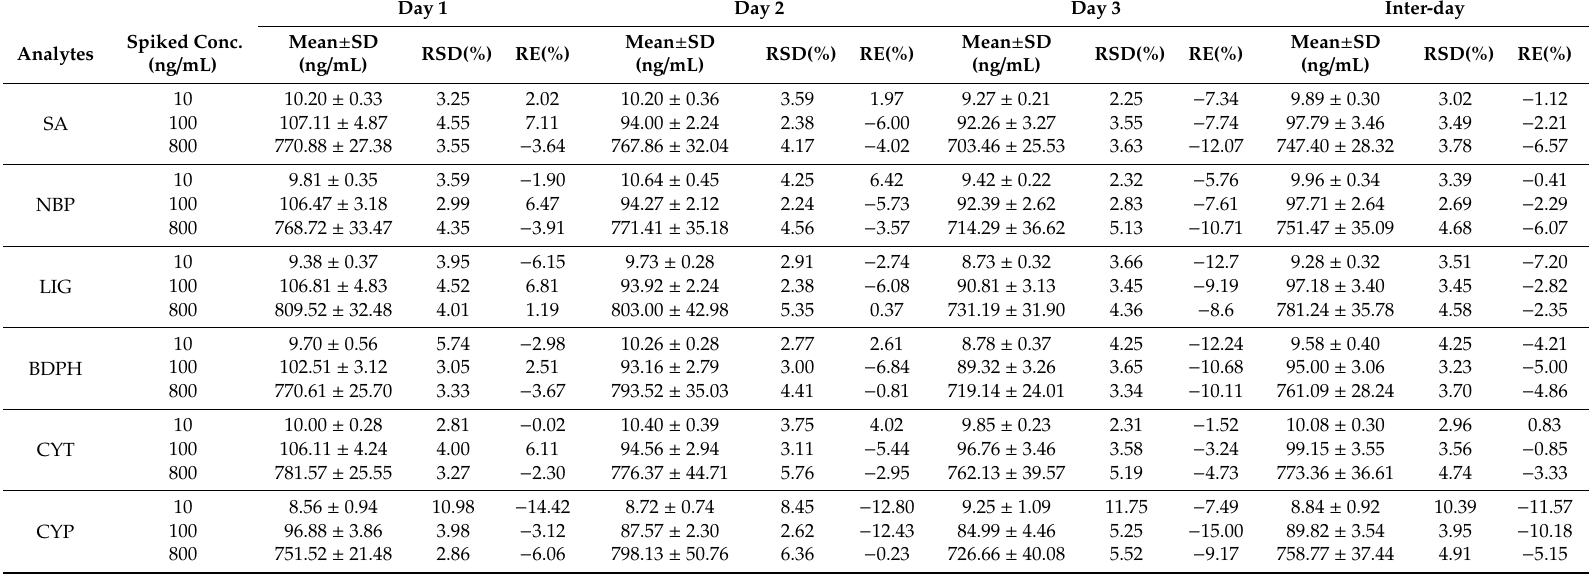
Table 2. Intra-and inter-day precisions and accuracies of the analytes in rat cerebral cortex homogenate ( n =